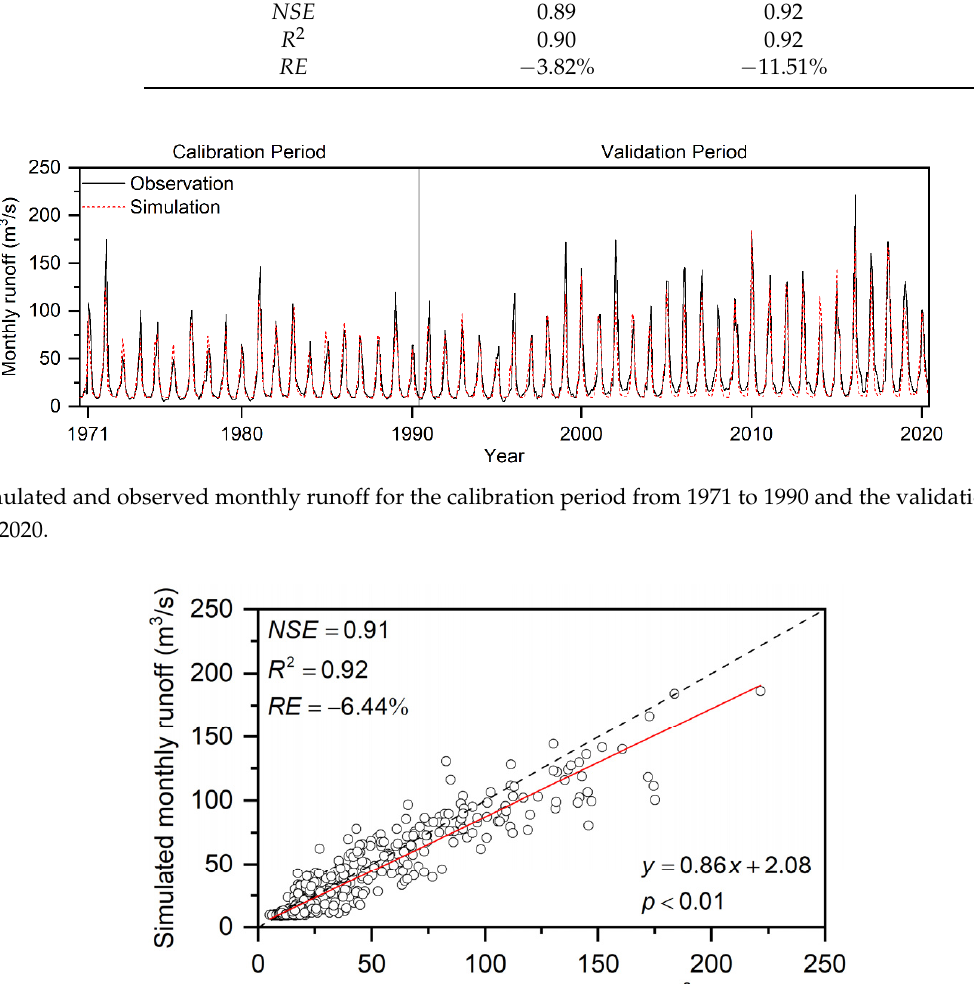
Figure 6. Comparison of the simulated and observed monthly amounts of runoff for the entire simulation period from 1971 to 2020.